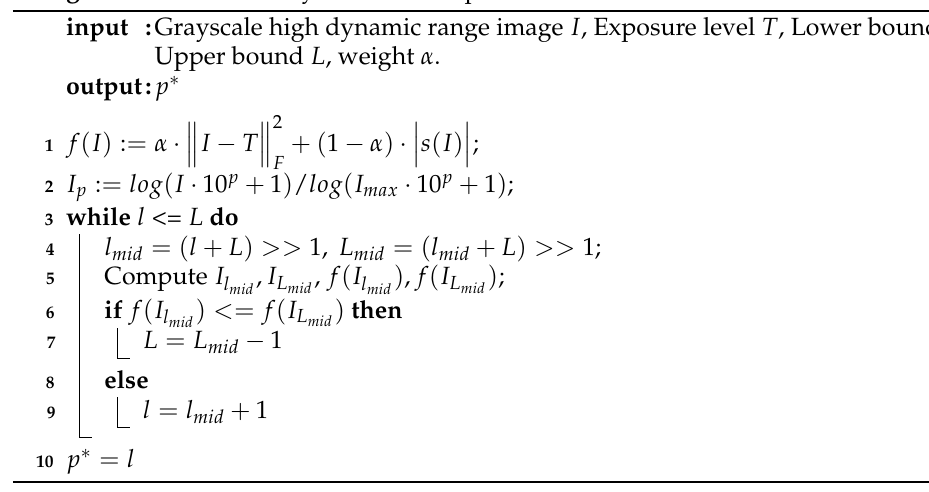
Algorithm 1: Trichotomy method for optimum value